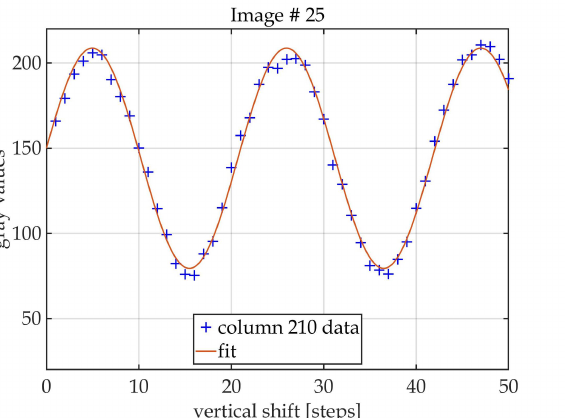
Figure 14. Vertical movement of the fringe pattern, each step = 50 µ m, total shift = 2.5 mm.